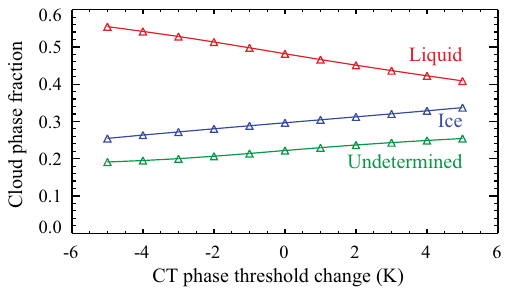
Figure 5. The expected sensitivity of the EPIC cloud thermody- namic phase algorithm, based only on cloud temperature thresholds, to errors in cloud temperature. Here monthly global cloud phase fractions – i.e., the fraction of cloudy pixels determined to be liquid (red line), ice (blue line), and undetermined (green line) phases – as a function of the CTT threshold perturbation are plotted. Data are from Aqua MODIS, April 2005.